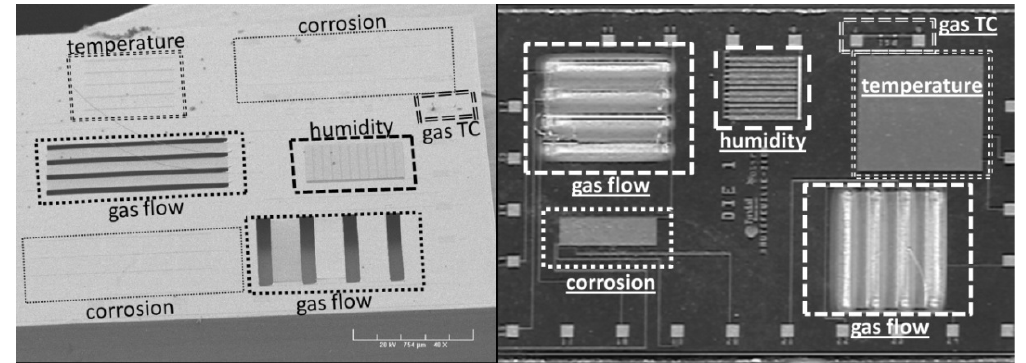
Figure 4. SEM and microscopic images of two examples of MEMS multisensor dies with different